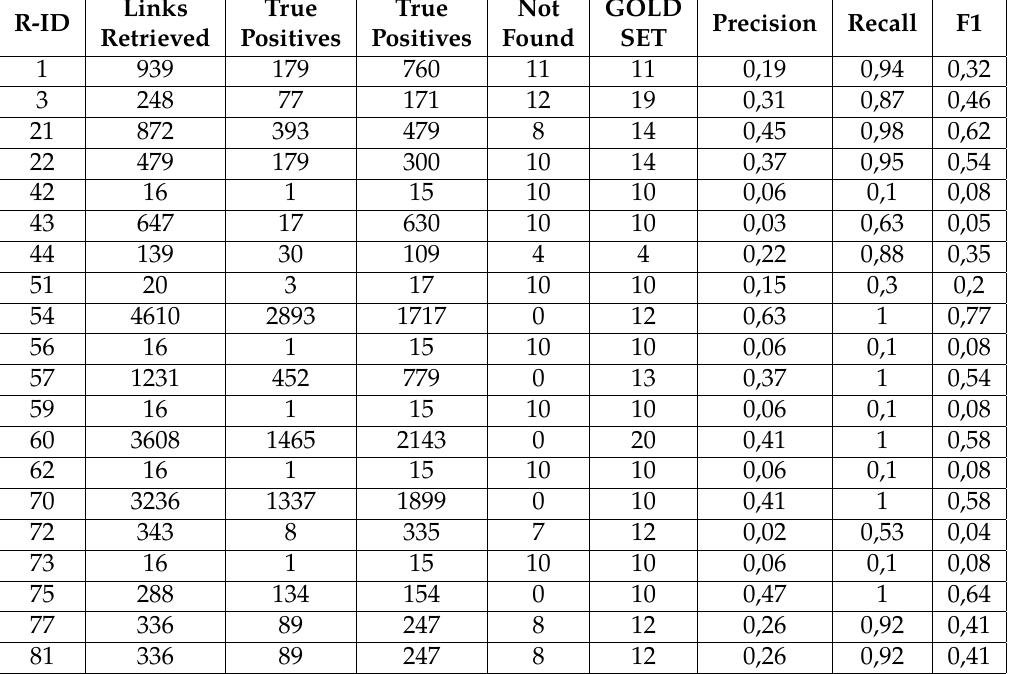
Table 7: FGTHunter results for TAPAS requirements.